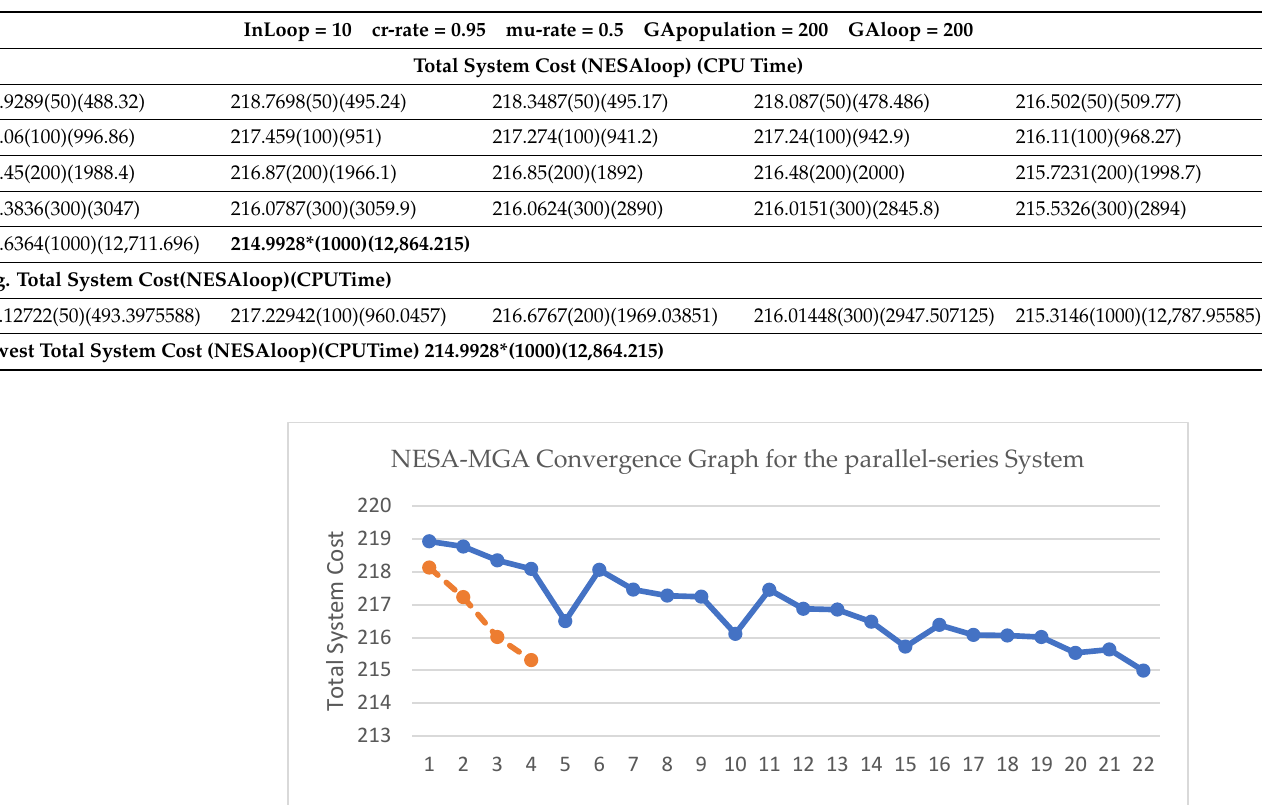
Table 21. The total system costs of 20 simulation runs obtained by NESA–MGA for the parallel- series system.